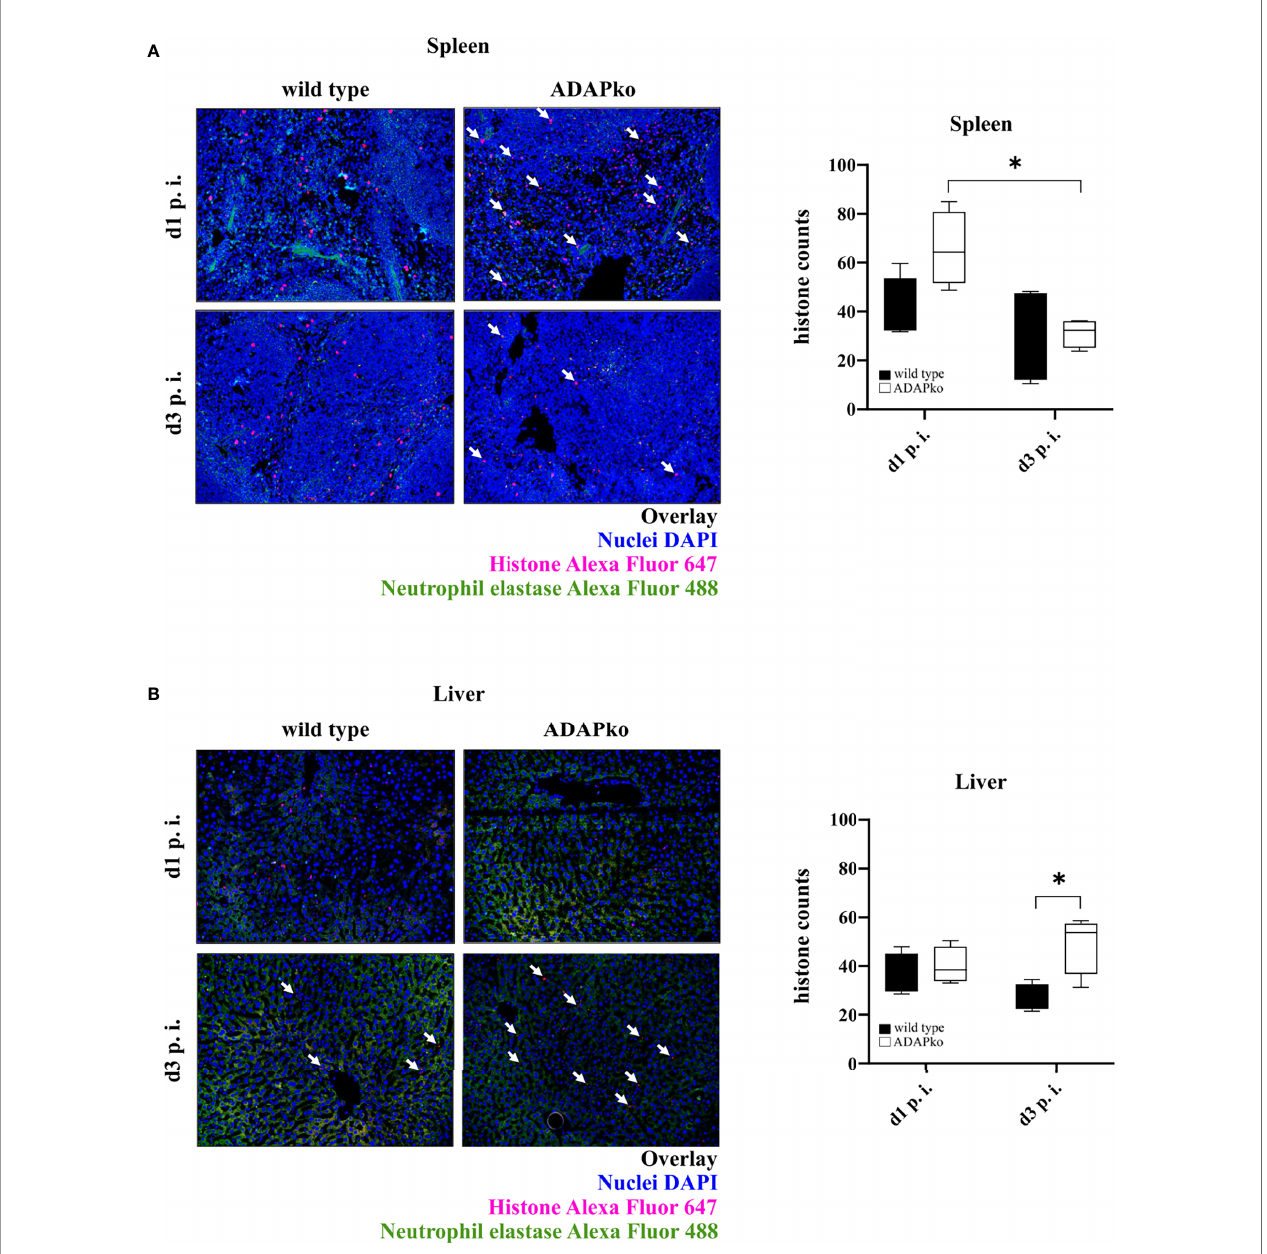
FIGURE 6 | Distinct changes in NET formation by neutrophils from ADAP-de fi cient mice in response to in vivo Listeria monocytogenes ( Lm ) infection. Wild type ( ▪ ) and ADAPko ( ▫ ) mice (age: 10 – 14 weeks) were infected i.v. with 2.5 × 10 4 CFU Lm (strain 10403S) and sacri fi ced at the indicated times post infection. Formalin- fi xed tissue slices were stained with primary antibody (neutrophil elastase (NE) and histone H3) and subsequently with the secondary antibody (Alexa Fluor 488 donkey anti-rabbit IgG and goat anti-rat IgG Alexa Fluor 647) as well as DAPI for nuclei staining. Four pictures per slide (three different layers) at a magni fi cation of ×200 were taken, and histones were counted using Image-Pro Plus 6 (double-blinded). Representative pictures show the overlay of the nuclei (colored in blue), histones (colored in red), and neutrophil elastase (colored in green) in (A) spleen and (B) liver tissues, whereas white arrows highlight the histones. Summary plots show the means of counted histones. Data are depicted as box and whiskers ± min to max for n = 4 individually analyzed mice per genotype out of one experiment. Statistical analyses were performed using two-way ANOVA with Bonferroni ’ s post-hoc test (*p < 0.05). NET, neutrophil extracellular trap; ADAP, adhesion and degranulation-promoting adaptor protein; ADAPko, adhesion and degranulation-promoting adaptor protein